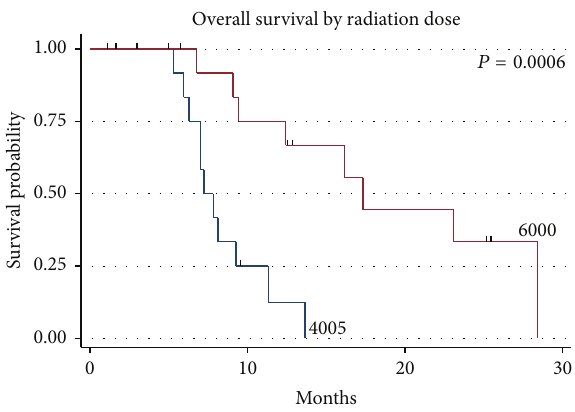
Figure 2: Kaplan Meier overall survival for all 31 patients for hypofractionated 4005 centiGray IMRT (blue line) and convention- ally fractionated 6000 centiGray IMRT (red line).